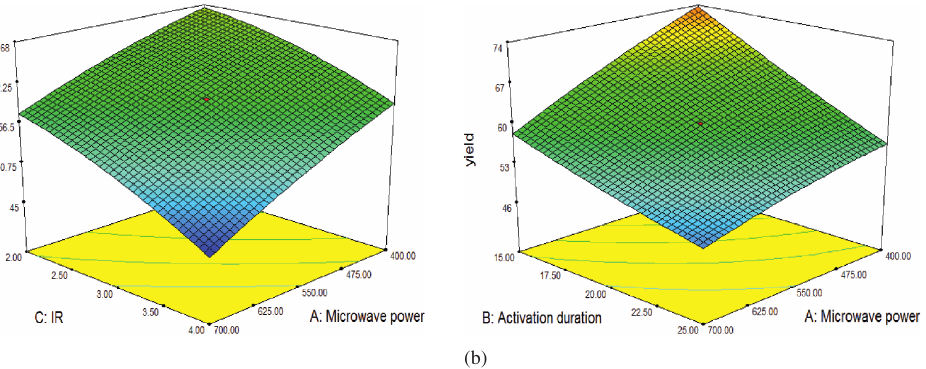
Figure 5: Three-dimensional response surface plot of yield: effect of microwave power and IR (a), effect of microwave power and activation duration (b).